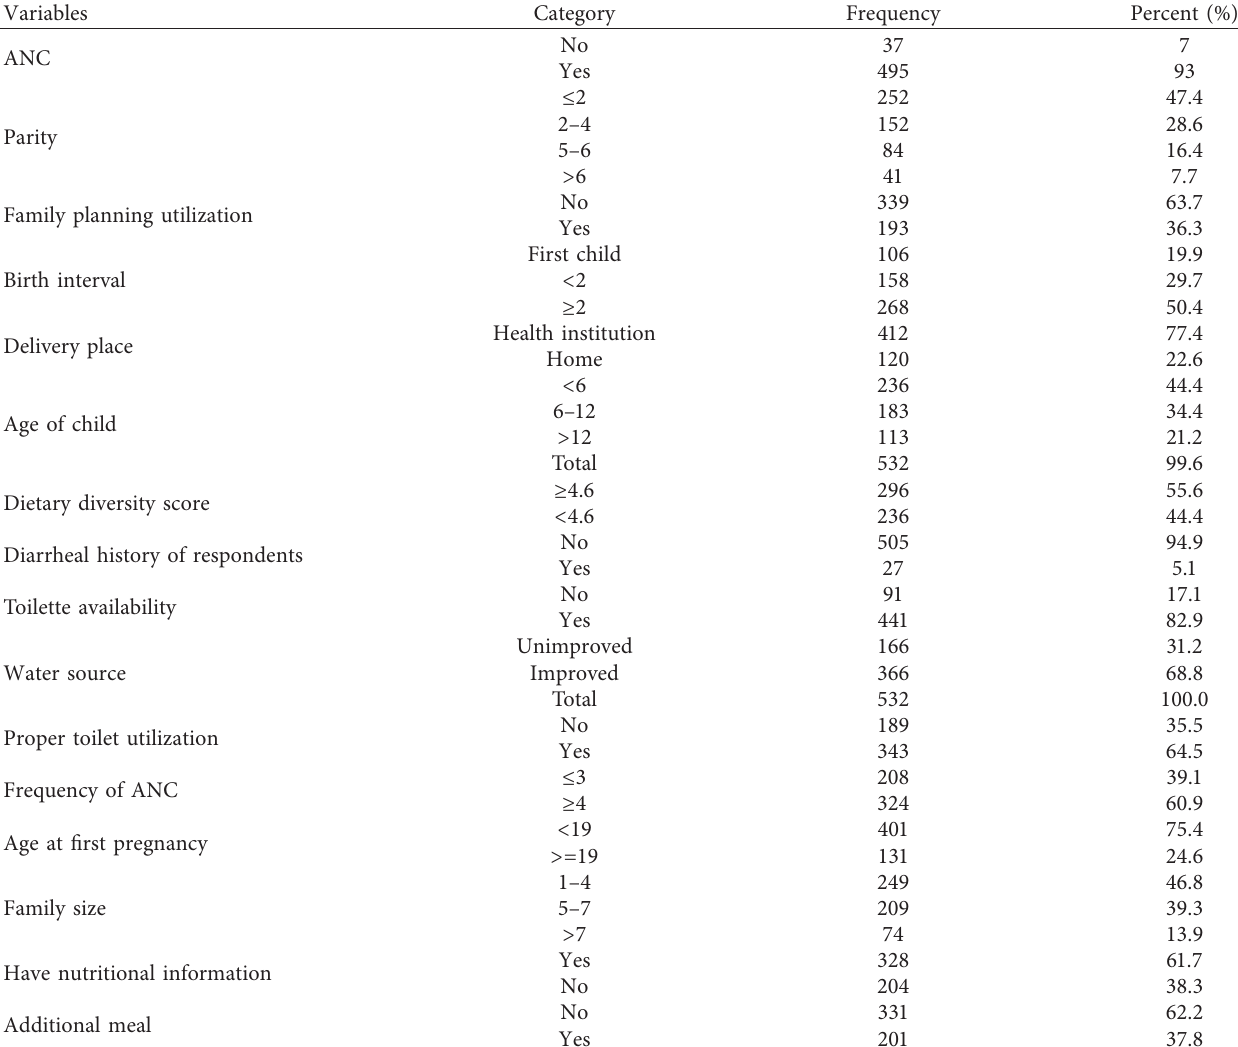
Table 3: Maternal healthcare and feeding practice of lactating women ( N � 532) in Moyale District, Borana, Southern Ethiopia, 2018.